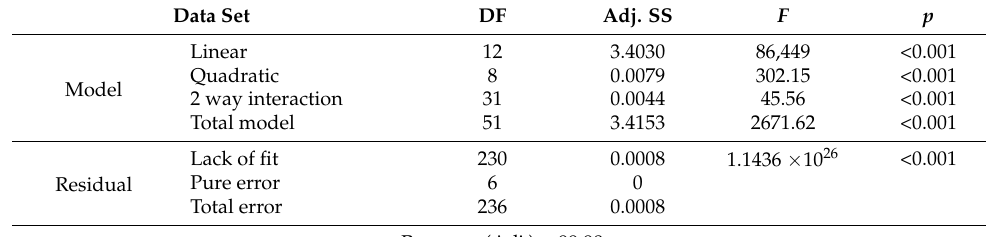
Table 7. Result of analysis of variance (meta-model for strategy 3).